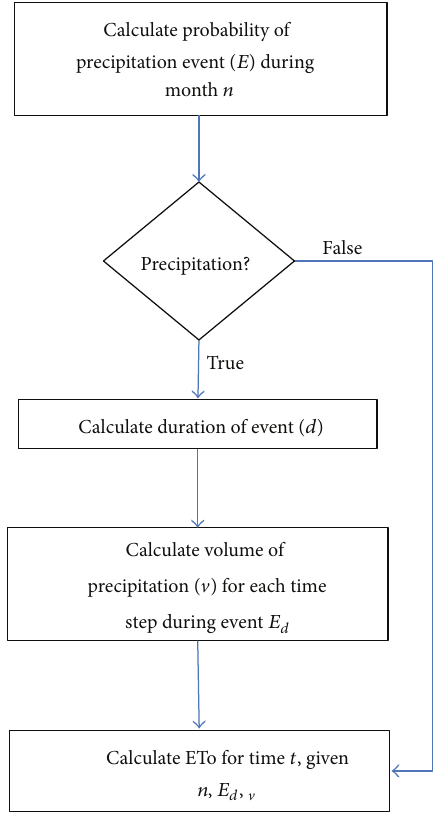
Figure 3: Simulation model sampling method for evapotranspira- tion and